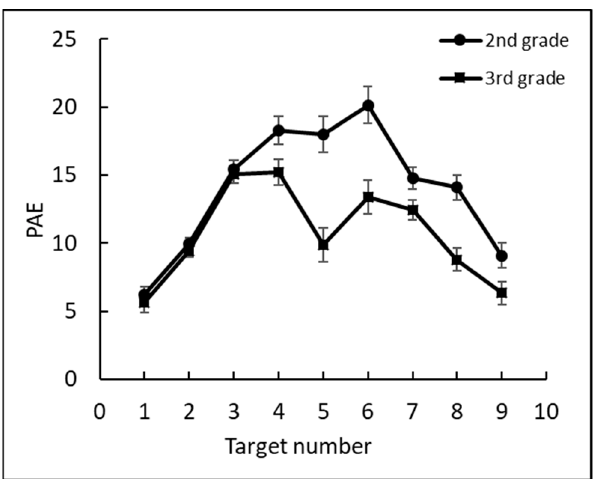
Figure 10. The percentage of absolute error (PAE) by target number per grade.